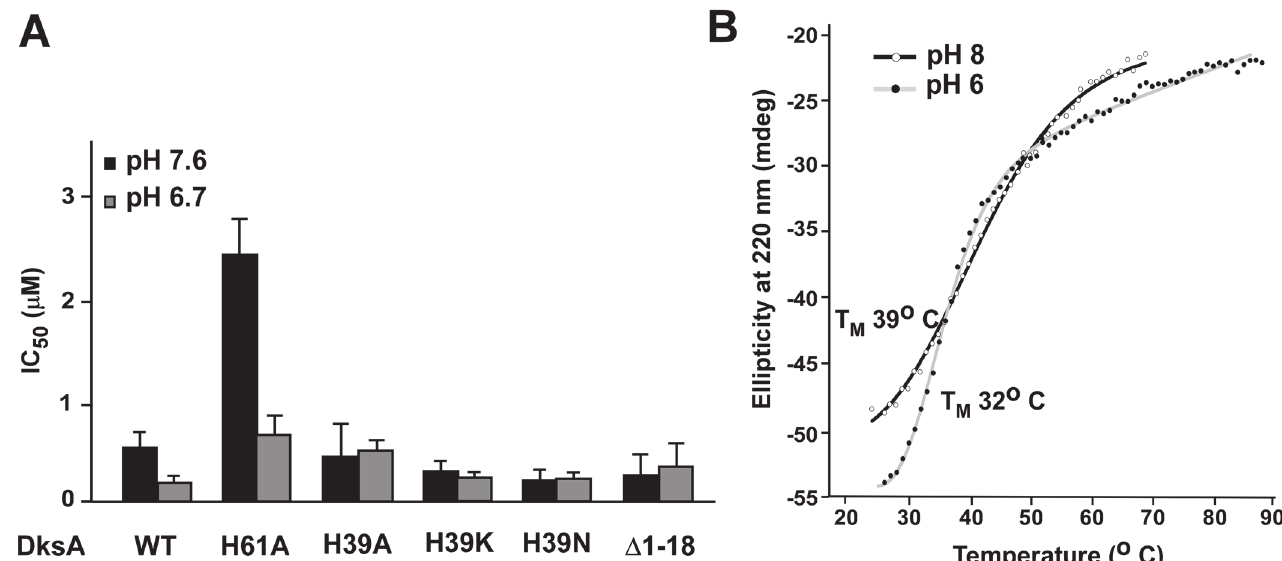
Fig 6. Substitution of His39 alters DksA sensitivity to pH. (A) The effect of pH on DksA variants. DksA activity and IC 50 calculations were determined as described in Fig. 3A with the rrnB P1 promoter. Experiments were performed at least three times at each pH. (B) Thermostability of DksA H39A is low and relatively insensitive to pH. Thermostability was determined as described in Fig.